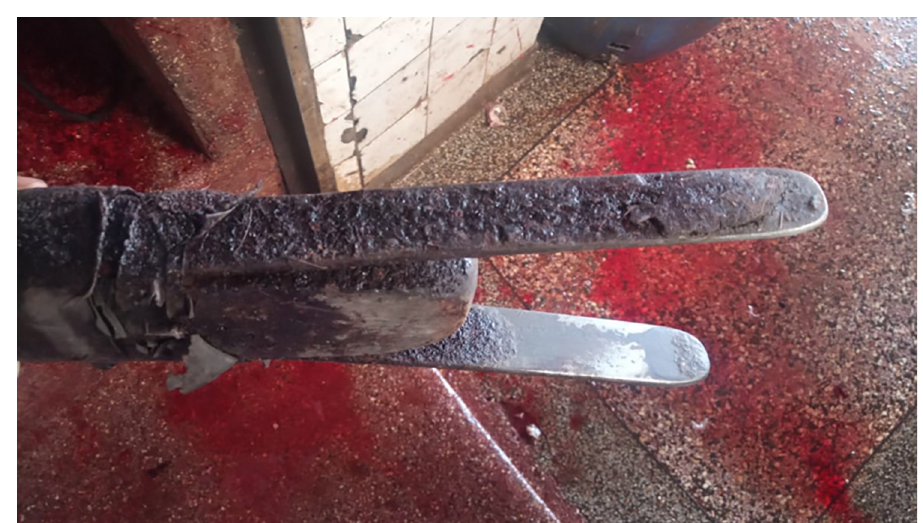
Fig 5. An image showing the dirty and corroded electrodes on the stunning device.